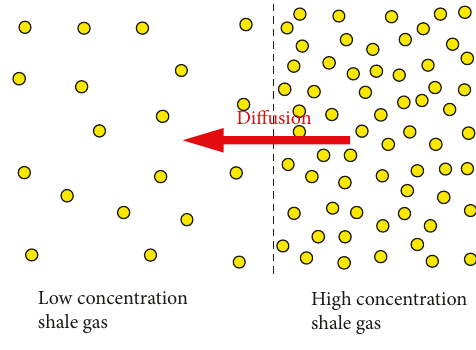
Figure 3: Diagram of Fick di ff